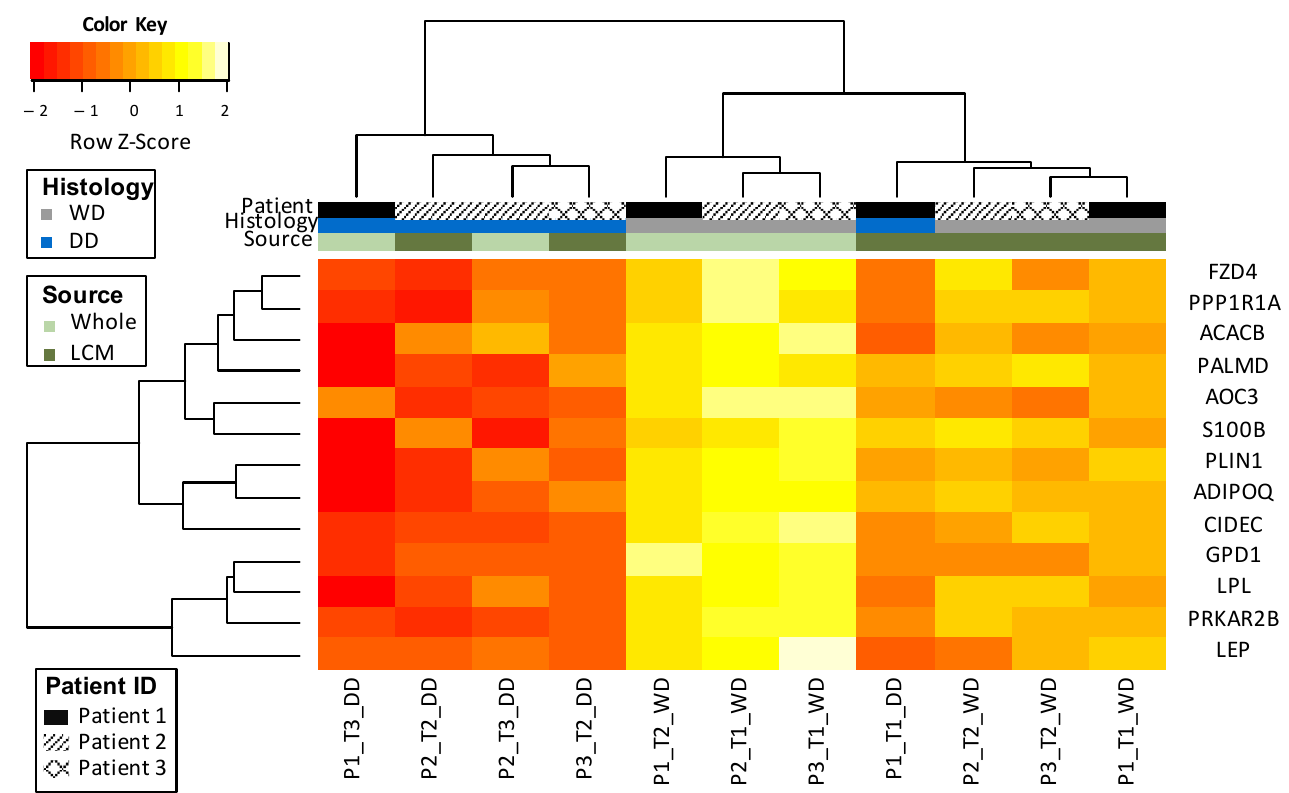
Figure 3. Segregation of liposarcoma samples by the 13-gene differentiation signature. WD, well-differentiated liposarcoma; DD, dedifferentiated liposarcoma; LCM, laser-capture microdissection.